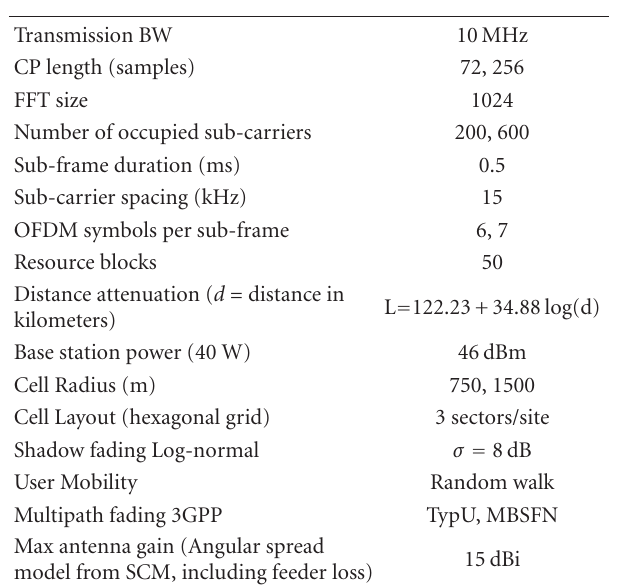
Table 1: Simulation parameters for 10MHz bandwidth.